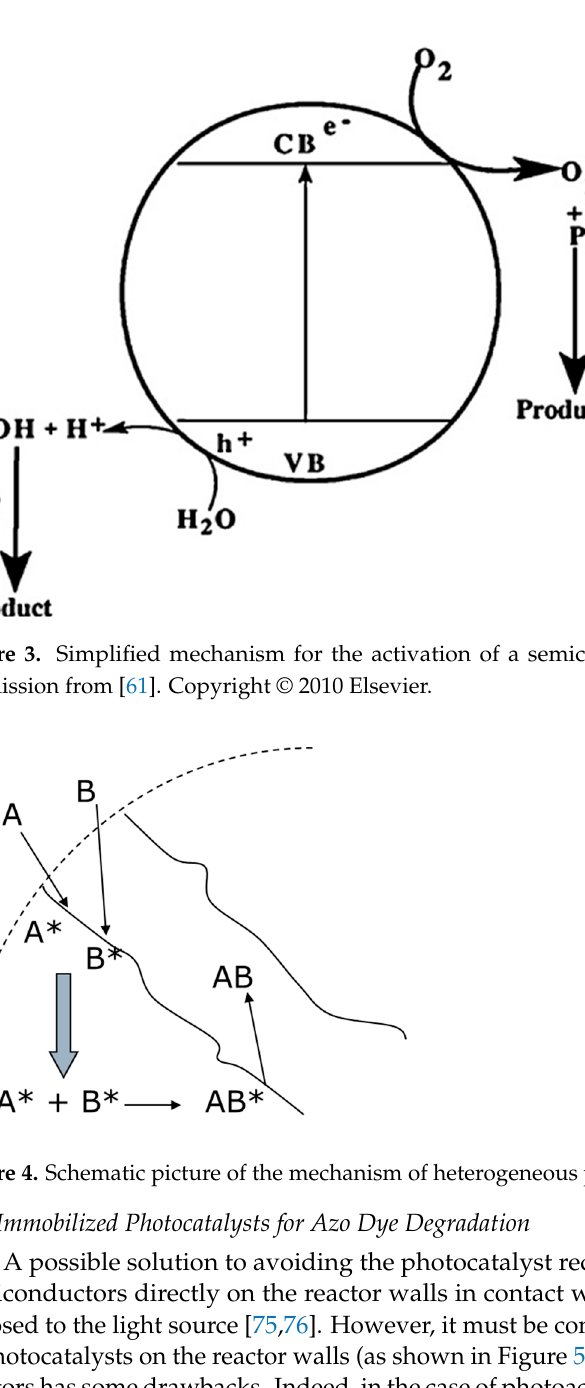
Figure 4. Schematic picture of the mechanism of heterogeneous photocatalysis.